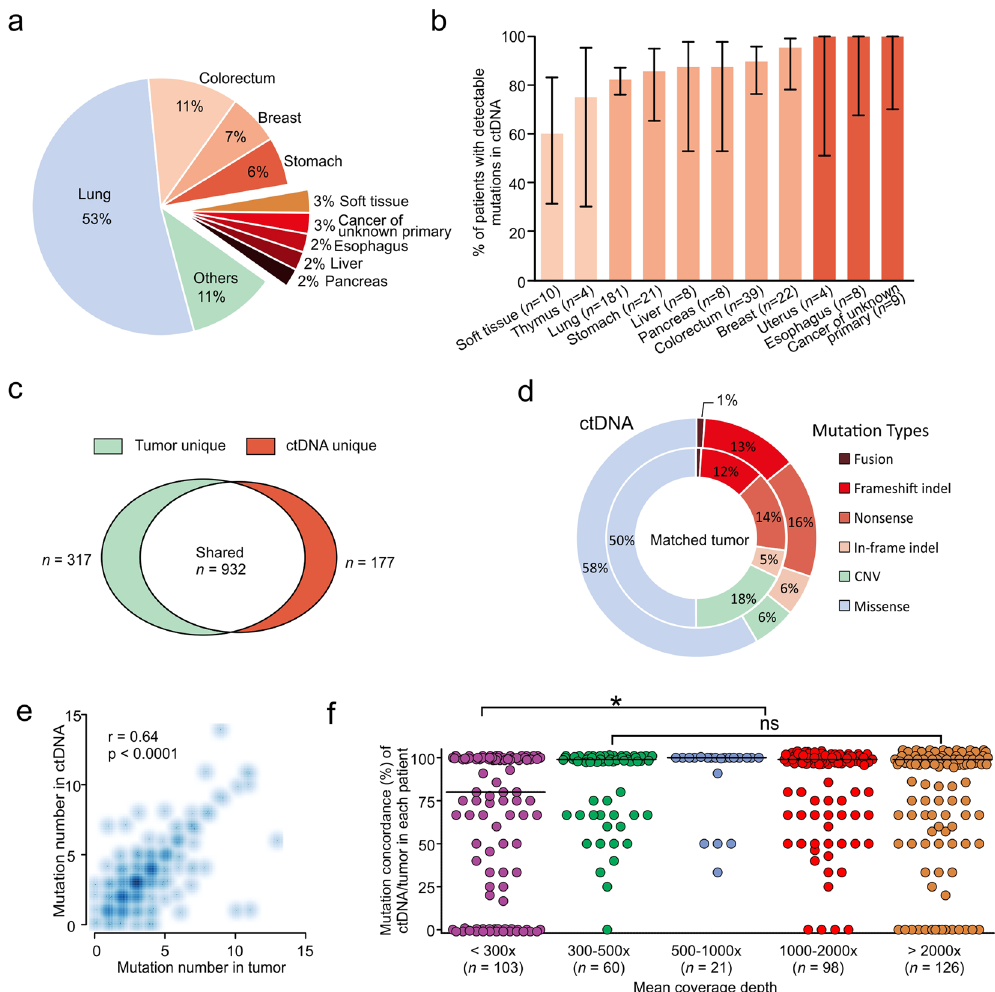
Figure 3. Mutation detection concordance between matched tumor and ctDNA samples in cohort I. ( a ) The composition of different tumors classified by their tissue origins. Tissue types that have less than 4 cases represented in the study are classified as “Others”. ( b ) The percentage of patients with mutations detected in ctDNA within different tumor types. Tumor types with less than 4 cases are not shown. ( c ) Shared and unique mutations identified in tumor and ctDNA samples. ( d ) The composition of mutation types in tumors and ctDNA. ( e ) Correlation of mutation numbers in ctDNA and matched tumors (Spearman’s rank test, p < 0.0001). The scatter dots were plotted according to mutation numbers identified per patient in ctDNA and matched tumors and the density represents the number of patients. ( f ) The correlation between mutation detection concordances in the matched tumor-ctDNA samples and sequencing coverage depth. The concordance rate was calculated by dividing the number of mutations in ctDNA to the number of mutations in matched tumor sample for each patient. Each dot represents one individual patient with median concordance rate shown by the black bar. * p < 0.05, Dunn’s multiple comparisons test; ns, not